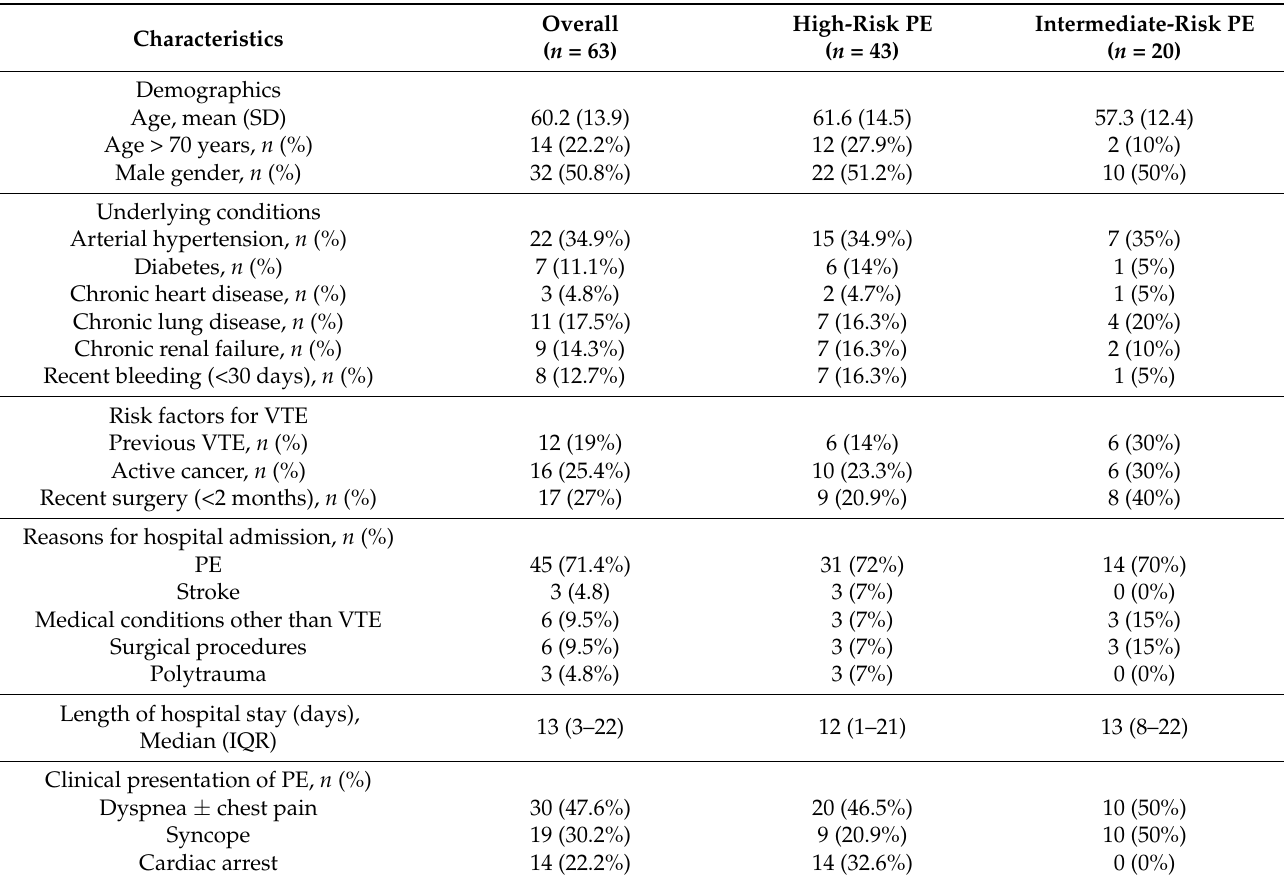
Table 1. Clinical baseline characteristics at pulmonary embolism